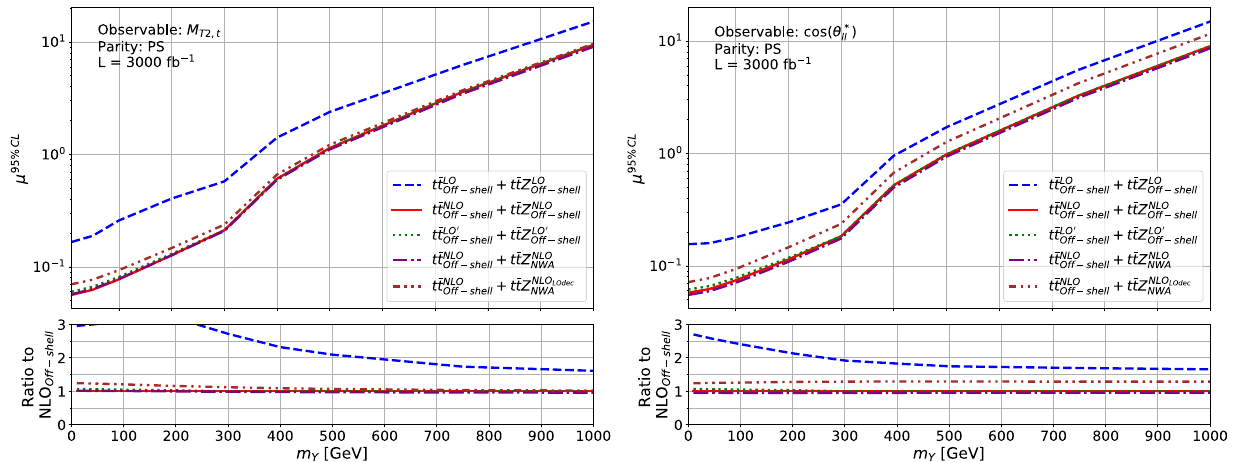
Fig. 16 Comparison of signal strength exclusion limits computed with differentbackgroundpredictionsforthepseudoscalarmediatorscenario with a luminosity of L = 3000 fb − 1 and using M T 2 , t (left) and cos (θ ∗ (right) as observables. Here, we add the t ¯ t off-shell prediction to the